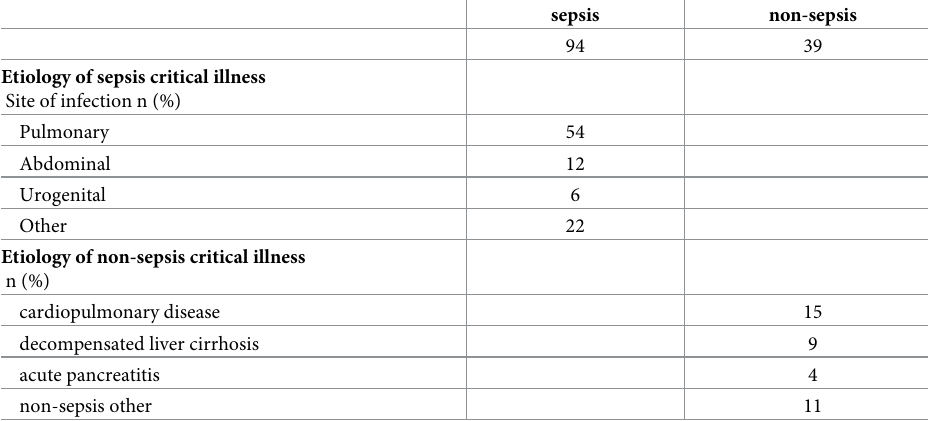
Table 3. Disease etiology of the study